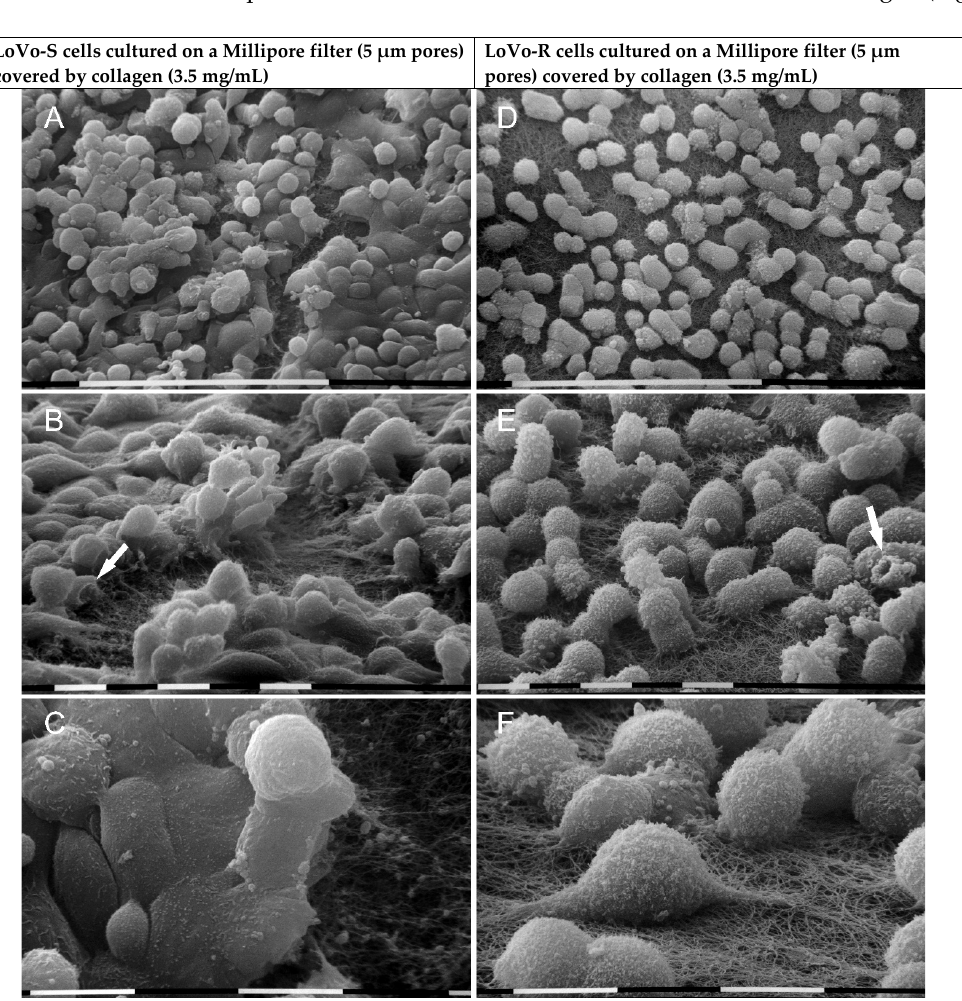
Figure 6. Ultrastructural morphological characteristics of LoVo-S and LoVo-R cells cultured for 24 h on Millipore/type I collagen mimicking a desmoplastic lamina propria. LoVo-S cells include polygonal cells in tight cell-cell contact with each other and adhering to the collagen fibrils, which are only partially visible. However, globular-shaped cells grow on the flattened ones ( A , B ). A funnel-shaped cell is detectable (arrow) ( B ). LoVo-S cells show few microvilli, but exosomes and microvesicles are embedded in the collagen fibril network ( C ). The LoVo-R cells look like globular-shaped cells next to each other, but no tight contacts are visible, so collagen fibrils are always distinguishable ( D ). A funnel-shaped cell is detectable (arrow) ( E ). The LoVo-R cells develop many microvesicles on their surface and appear strongly adherent to the fibrils with also filopodia invaginating the micropores of the collagen fibril network ( E , F ). Bar = 100 µ m ( A , D ) Bar = 10 µ m ( B , C , E , F